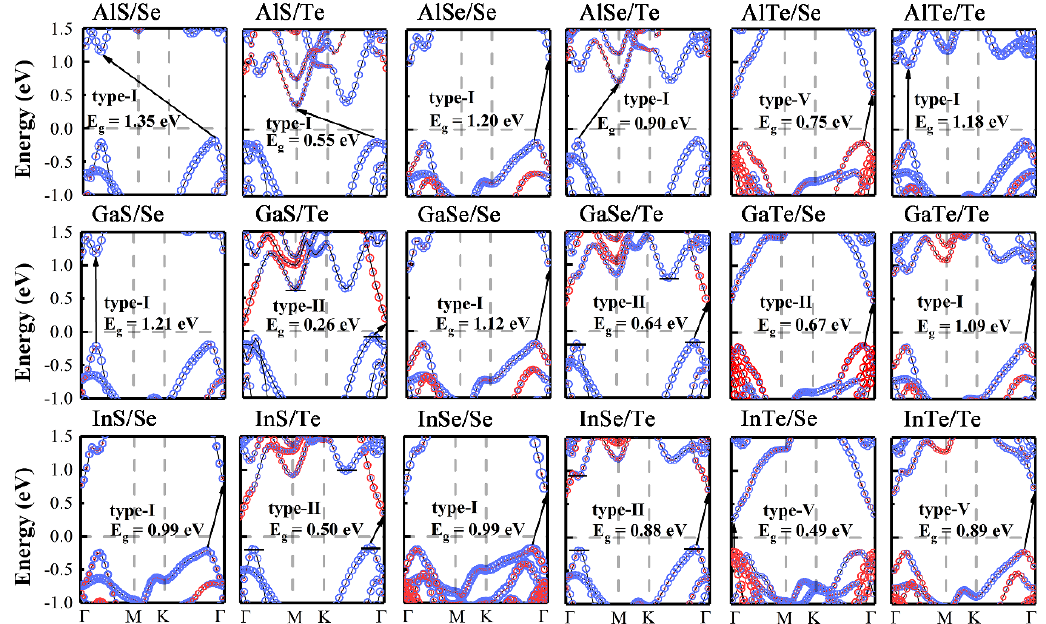
Figure 3. Projected band structures of MX A /X B heterostructures by HSE hybrid functional method. Red and blue circles represent projected weight of MX A and X B monolayers, respectively.